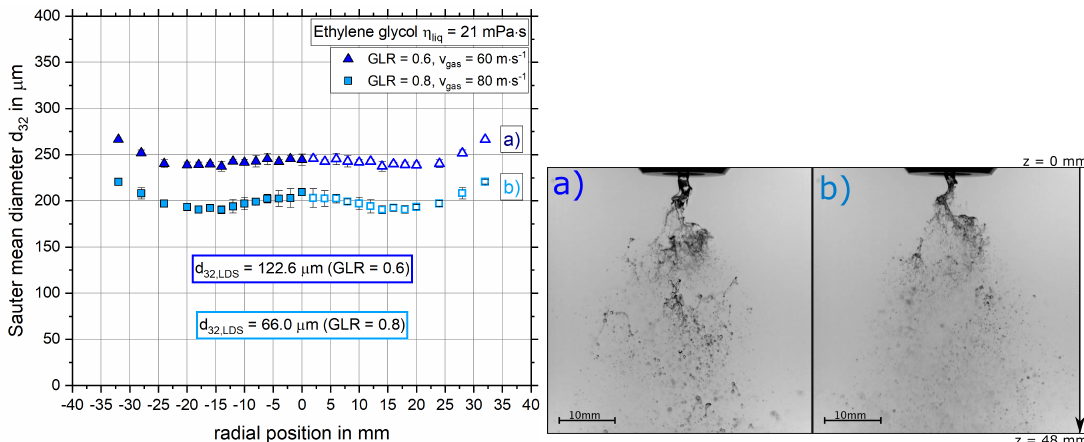
Figure 6. Radial distribution of the Sauter mean diameter at z = 150 mm below the nozzle orifice as a function of gas velocity (i.e., GLR ) for η liq = 21 mPa · s (dots: SpraySpy R (cid:13) , values: LDS) (left); High-speed camera images of the primary breakup for η liq = 21 mPa · s at ( a ) v gas = 60 m · s − 1 and ( b ) v gas = 80 m · s − 1